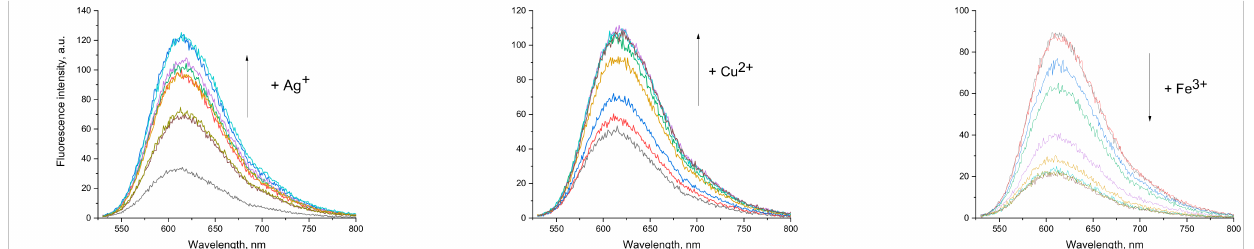
Figure 6. Illustrative examples of the observed changes in the fluorescence spectra of 1b upon increasing the respective metal cation concentration.